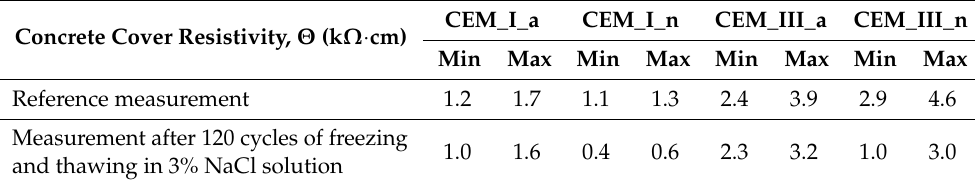
Table 5. Minimum and maximum values of concrete cover resistivity obtained from measurements before and after cycles of freezing and thawing specimens in a 3% NaCl